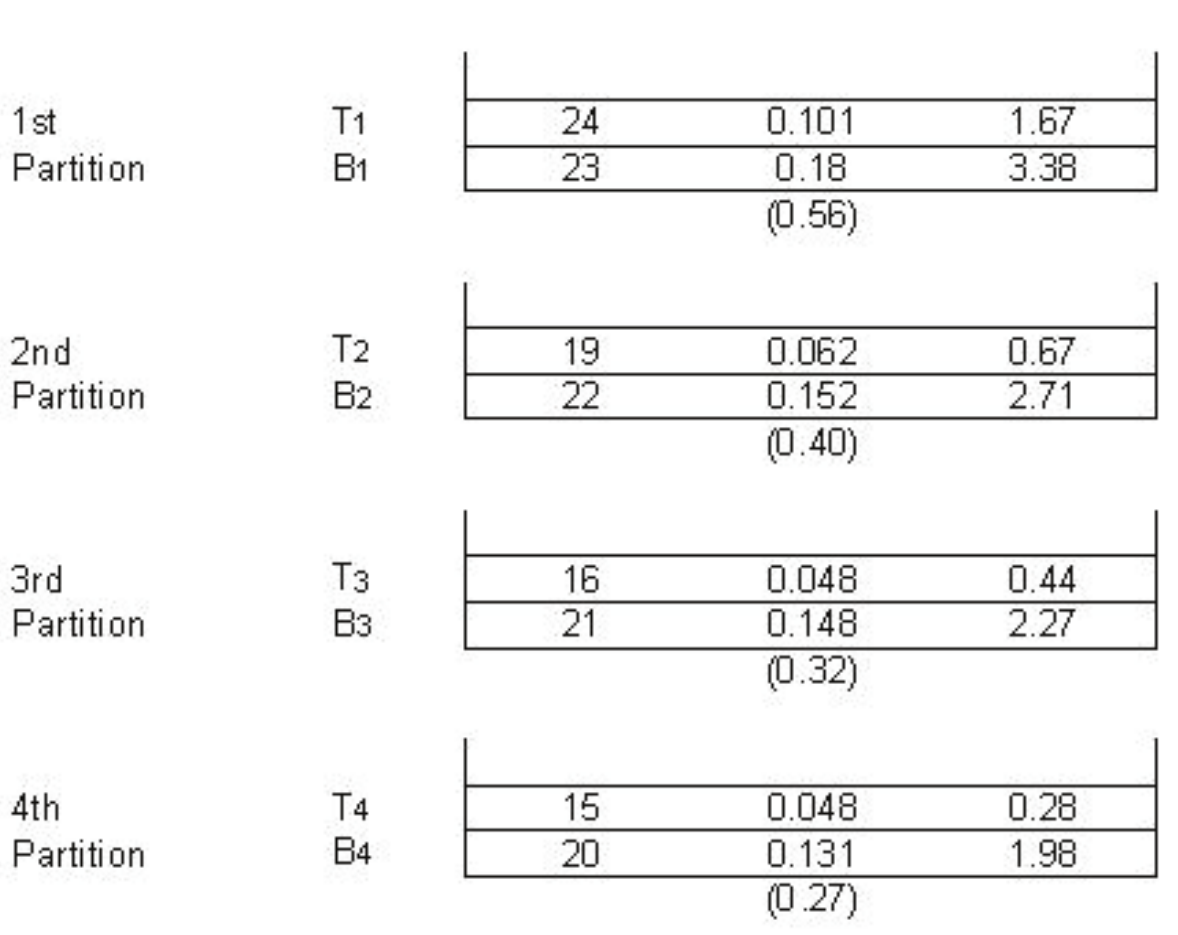
Figure 1. Four partition experiments were applied on Bothrops alternatus venom. The numbers on the left, (expressed in mm of hemolytic diameter), medium and right of each phase indicate phospholipase A 2 proteolytic activities according to the method of Wang and Huang (26) and the total protein concentrations (mg/mL), respectively. The numbers between parentheses are the protease partition coefficients, estimated as the ratio between protease activity in the top and bottom